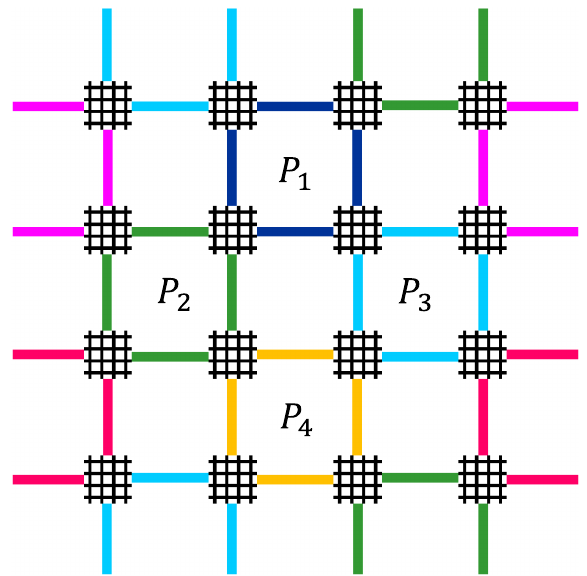
FIG. 4. Because the phases defined on the loops vary continu- ously and independently, the largest entropy configuration max- imizes their number; hence, it maximizes the number of loops or, equivalently, minimizes the length of each loop. This con- figuration can be thought of as independently fluctuating phases around loops on alternating plaquettes (depicted by different col- ors). That this loop crystal has maximum entropy originates from the fact that the “colors” or phases are continuous